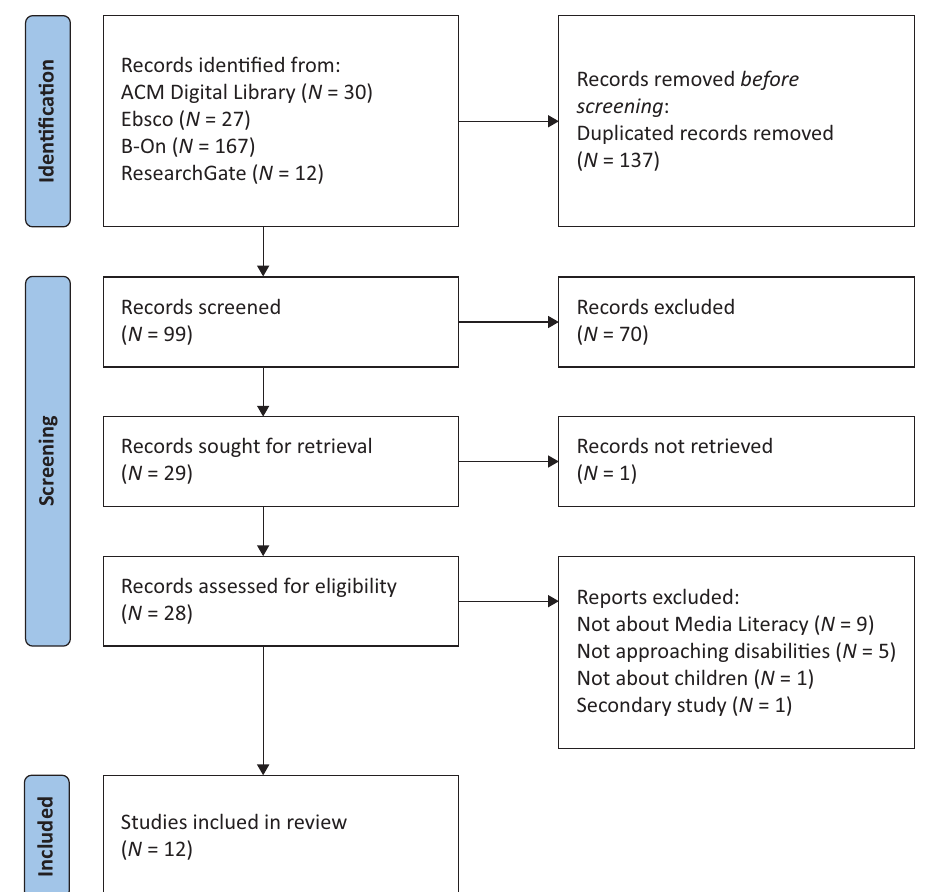
Figure 1. Flowchart of the selection process. Source: Authors’ work based on Page et al. (2021). phase was developed by applying the search strategy to the information sources and retrieving the obtained data. In the screening phase, the above‐defined crite‐ ria were applied at a superficial level, meaning that only titles, abstracts, and general information were consid‐ ered. In the eligibility phase, the criteria were followed by thoroughly analyzing each study before selecting the final